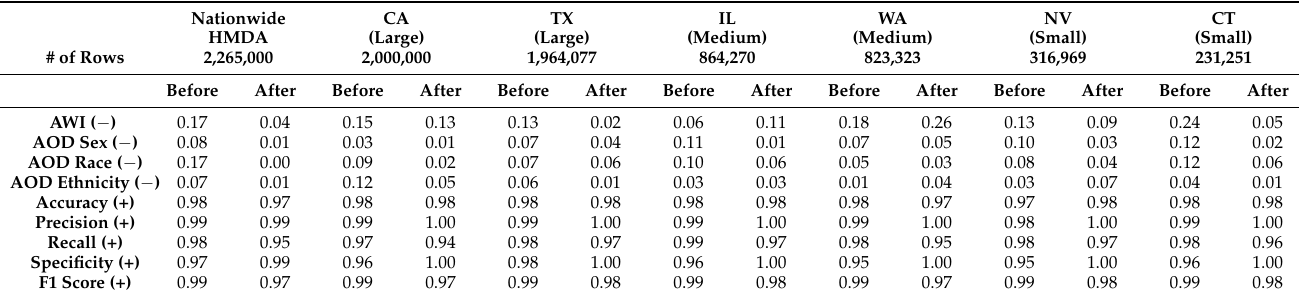
Table 3. Results before and after DualFair. AWI, AOD sex , AOD race , and AOD ethnicity the lower the better. Accuracy, Precision, Recall, Specificity, and F1 Score the higher the better. All values are rounded. AWI, AOD sex , AOD race , and AOD ethnicity are multiplied by 10 to accurately show the